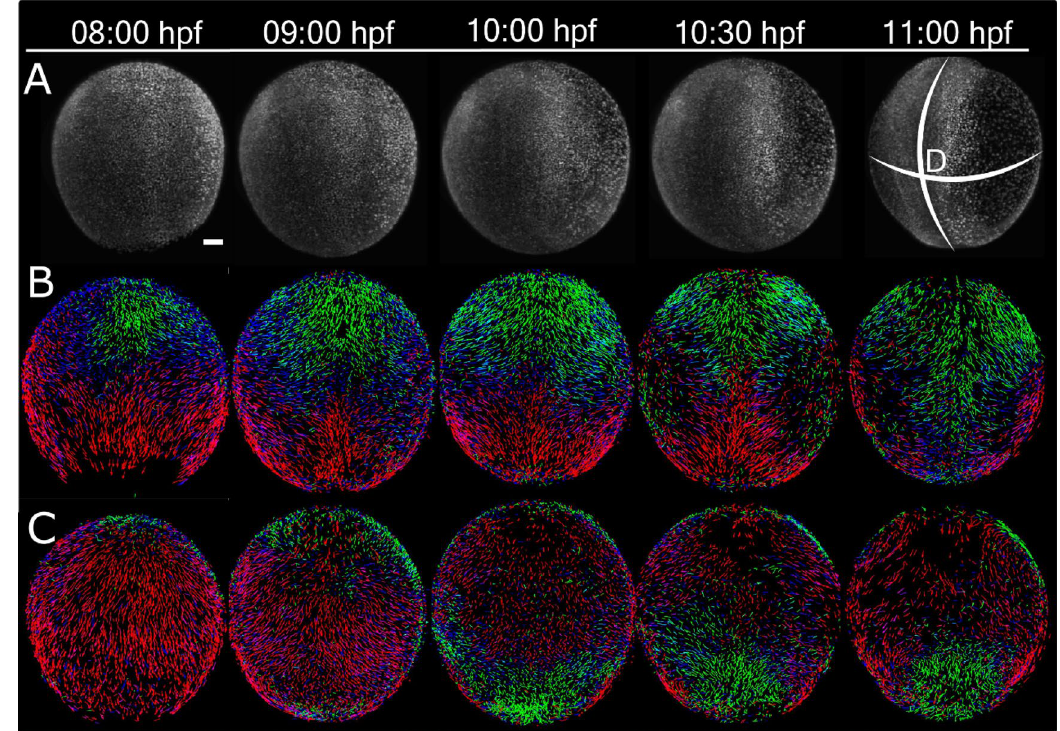
Figure 1. Velocity field maps of zebrafish from mid-gastrula to early segmentation stages. ( A ) Dorsal views of GFP-histone H2B-tagged embryos at 8 hpf (80% epiboly), 9 hpf (90% epiboly), 10 hpf (100% epiboly), 10.5 hpf (1 somite), 11 hpf (1–3 somite stages) respectively. Velocity field maps of the dorsal ( B ) and ventral ( C ) views of the velocity field maps. The length of the velocity vector represents the magnitude of the domain velocity over a 2-min interval. The color of the vectors represents the directions: Green towards animal pole, Red towards Vegetal pole, and Blue color represents the medio-lateral convergence or divergence. For all views, the embryo is oriented with anterior (A) and posterior (P) to the top and bottom respectively. Scale bar—10